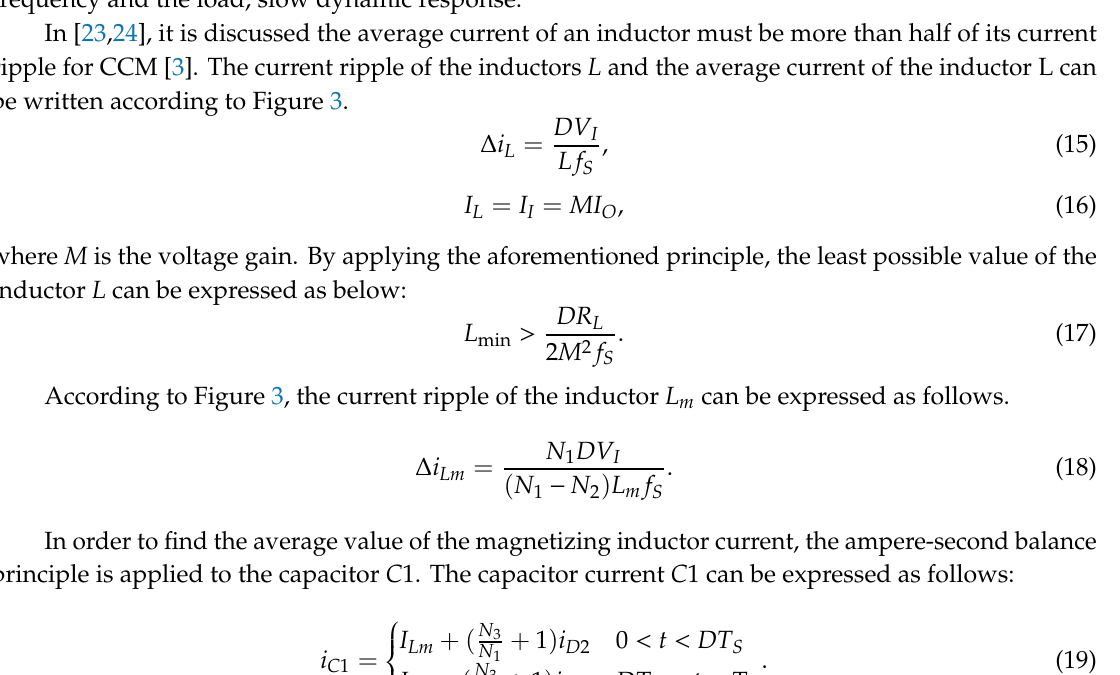
Figure 5. The voltage gain of the presented converter versus duty cycle.